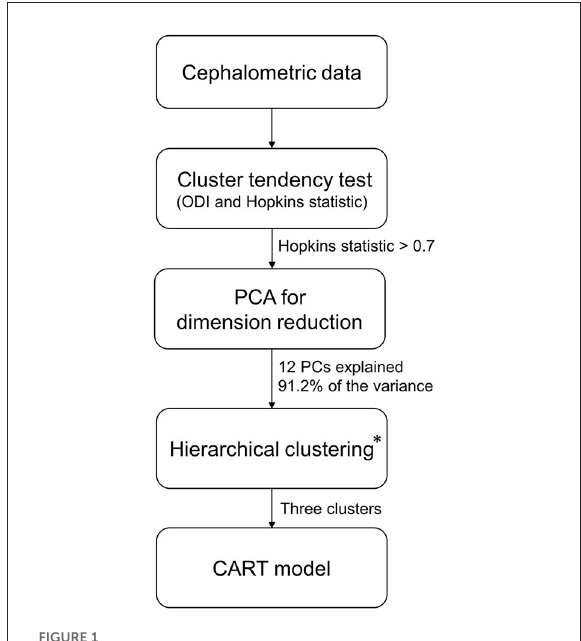
FIGURE1 Flowchart for cluster analysis. PCA, principal component analysis; PCs, principal components; CART, classification and regression tree. *Hierarchical clustering and three clusters were optimal clustering algorithm and number of clusters according to the methods in the